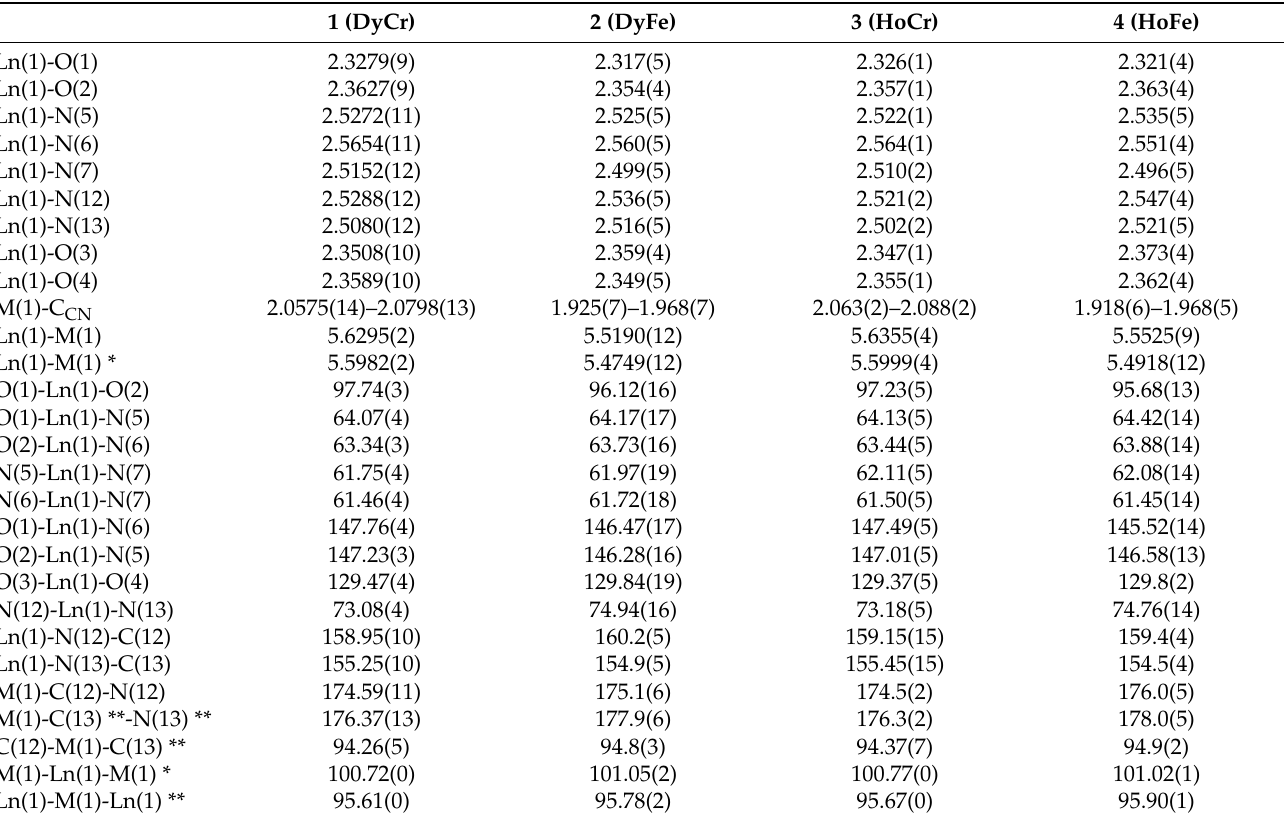
Table A1. Selected bond lengths (Å) and angles ( ◦ ) in 1 – 4